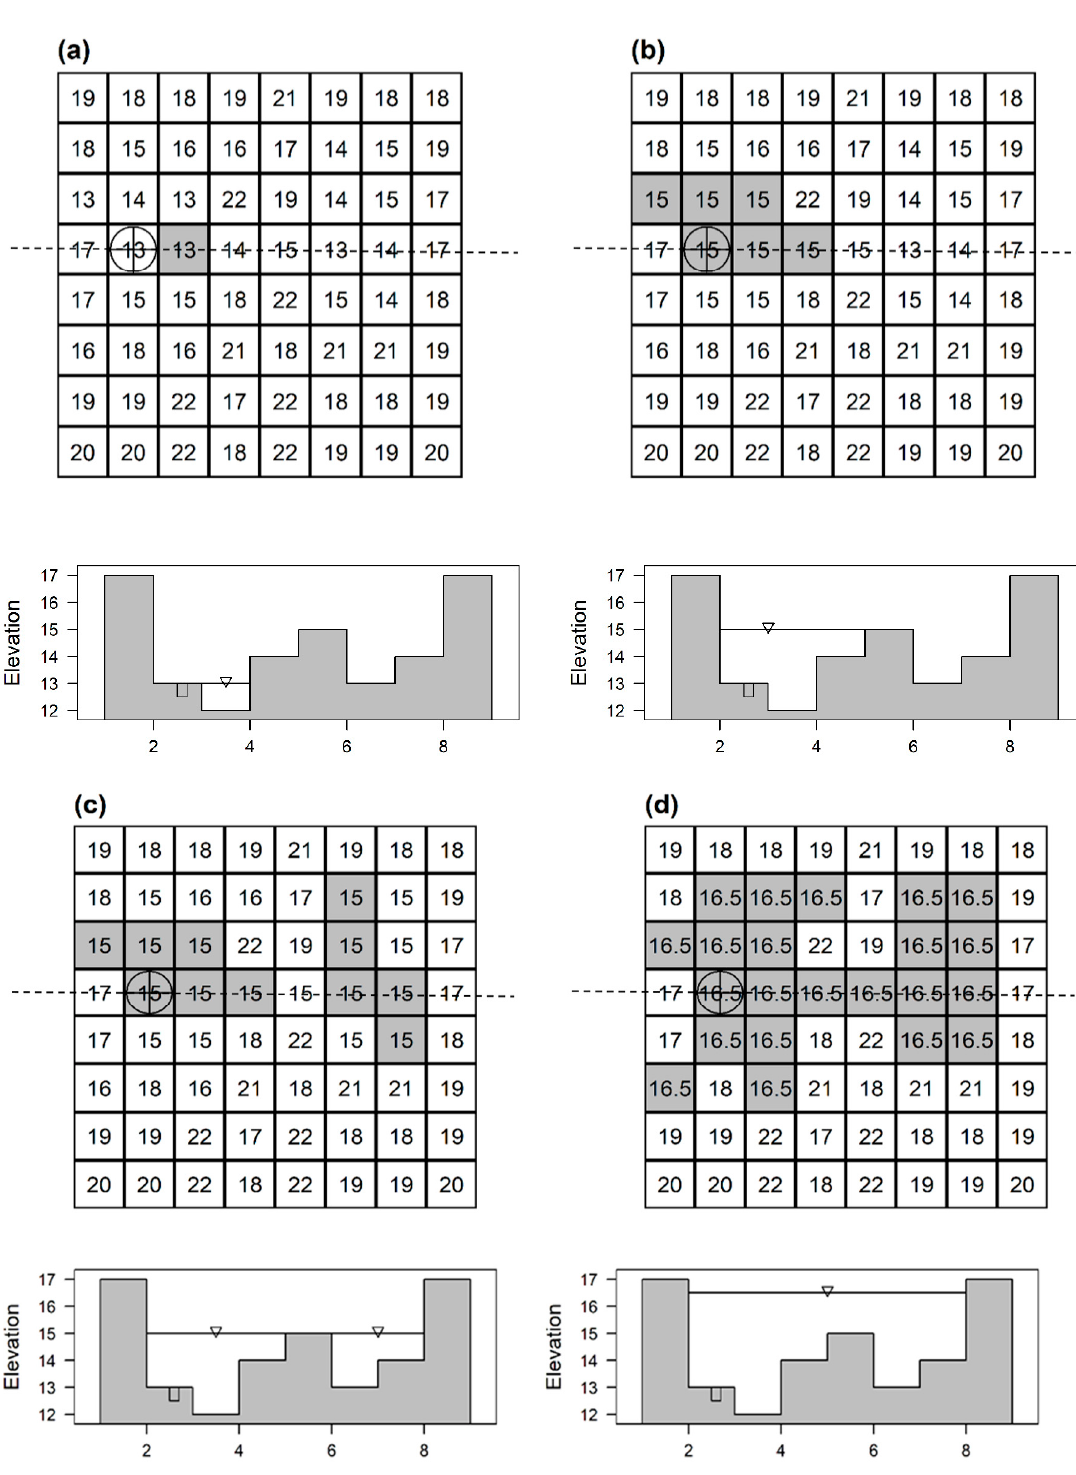
Figure 1. Schematic representation of the flood inundation modeling from one-manhole (the circle with cross) for different amounts of manhole overflow: ( a ) 1 unit, ( b ) 11 units, ( c ) 17 units, and ( d ) 46 units. The numbers inside the unshaded and unshaded grids represent surface elevation and flood levels, respectively. Dashed line represents the profile line.